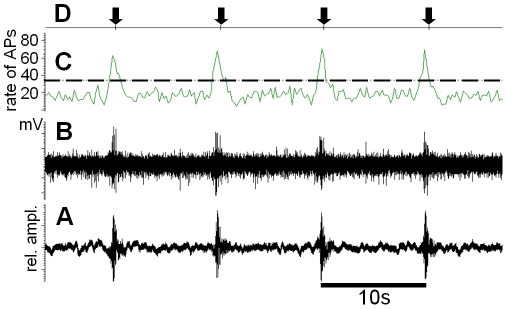
Reliability of detection of the tremulation signal.(A) Tremulation signal in the background noise of a leaf of A. magdalenae. (B) Action potential activity of the frontal leg nerve carrying fibres of the subgenual and hearing organ. (C) Instantaneous spike rate analysis of the recording shown in (B). Stippled line indicates threshold for detection (2 times SD of spontaneous activity). (D) Result of signal detection (arrows indicate “hits”).